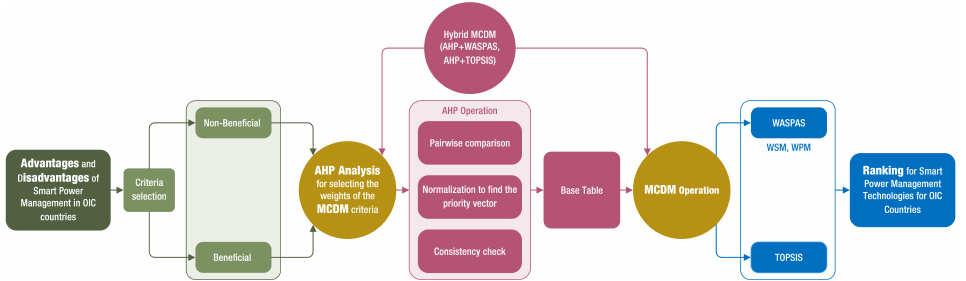
Figure 6. Process of hybrid MCDM